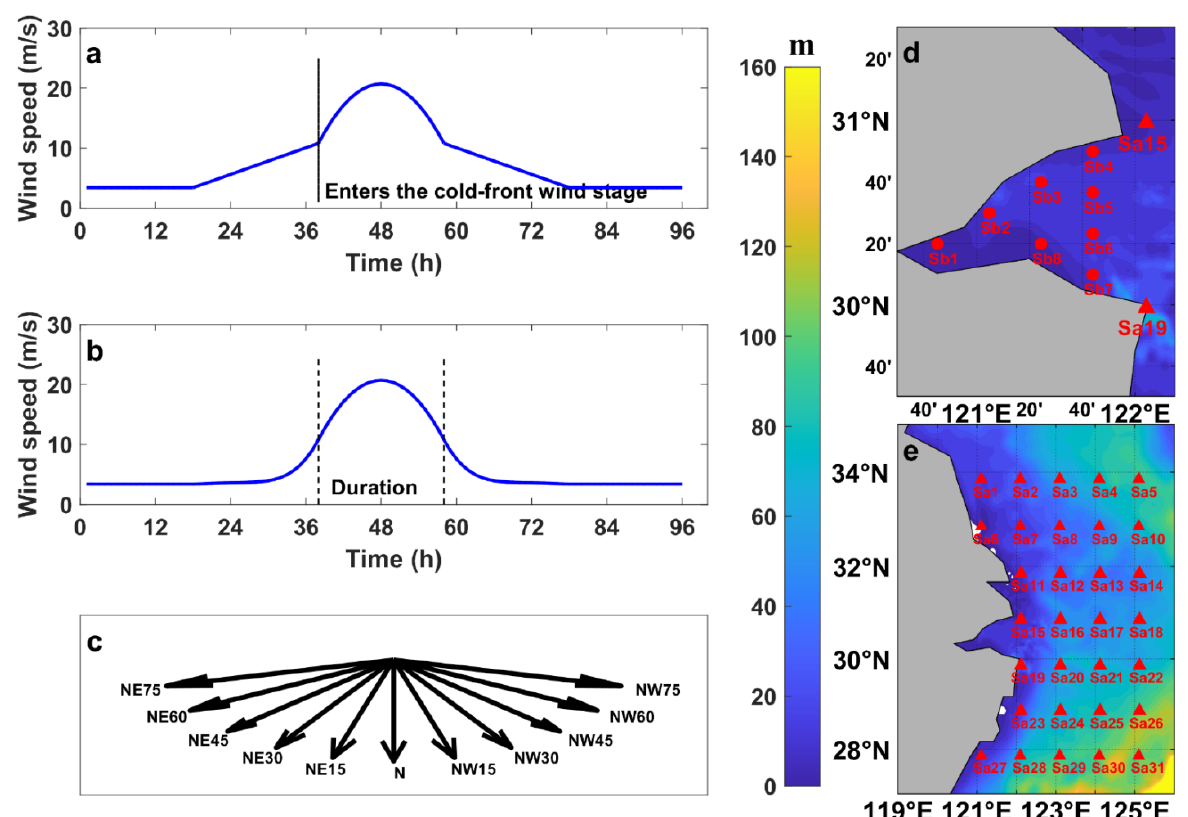
Figure 7. ( a ) Artificial wind field in previous studies; ( b ) Improved wind field used in the present study; ( c ) 11 cold-front wind directions: NW75 (75° north by west), NW60 (60° north by west), NW45 (45° north by west), NW30 (30° north by west), NW15 (15° north by west), N (north), NE15 (15° north by east), NE30 (30° north by east), NE45 (45° north by east), NE60 (60° north by east), NE75 (75° north by east); ( d ) Station group Sb, Hangzhou Bay; ( e ) Station group Sa, offshore Zhejiang.